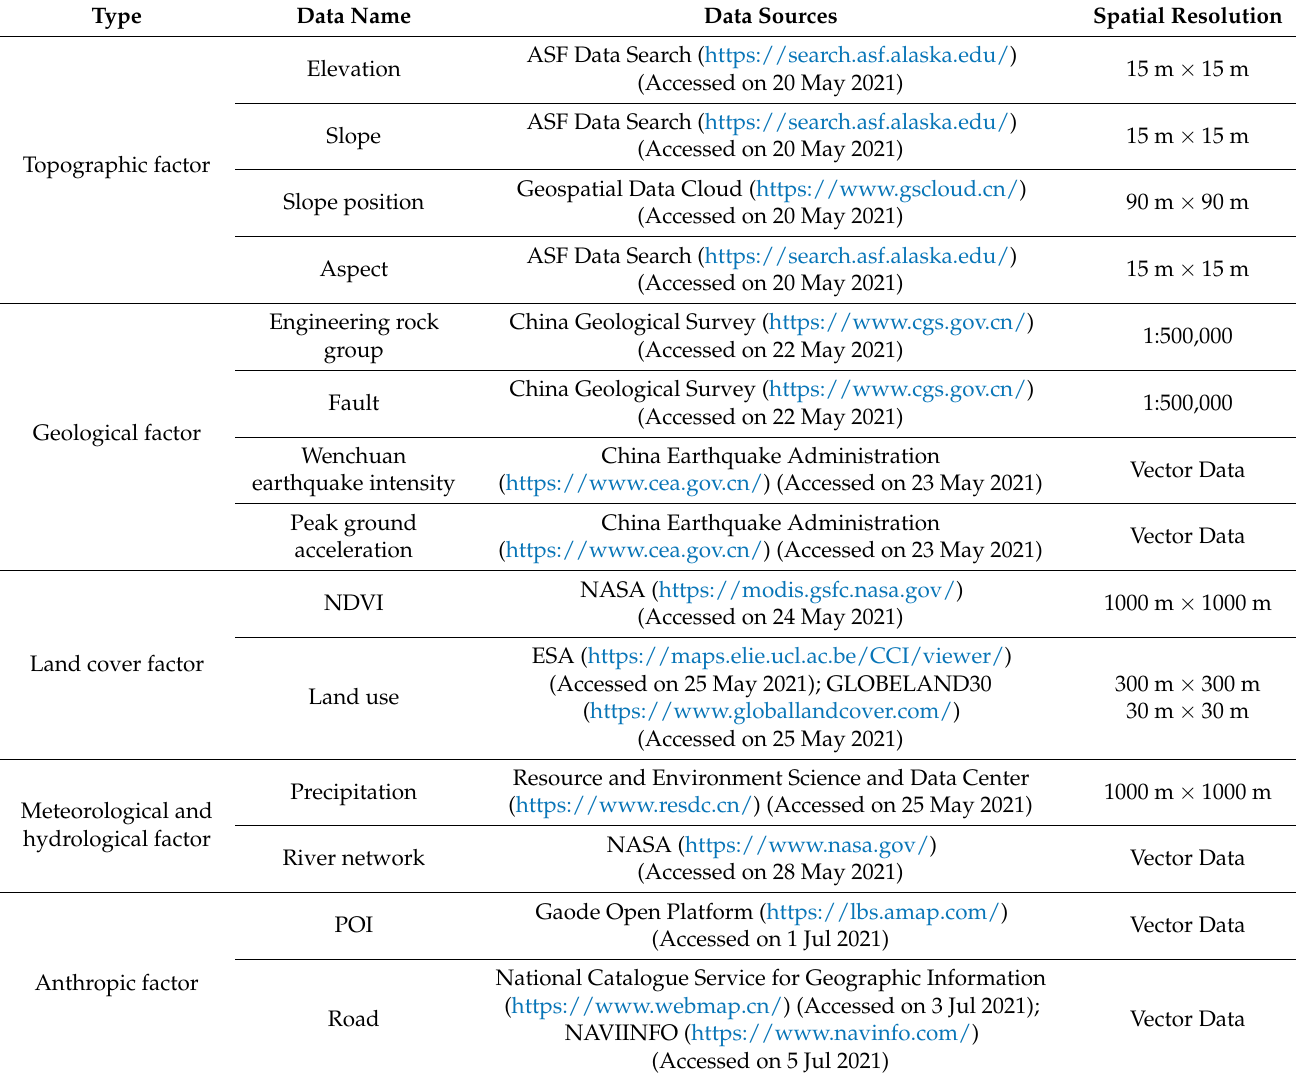
Table 2. Data and data